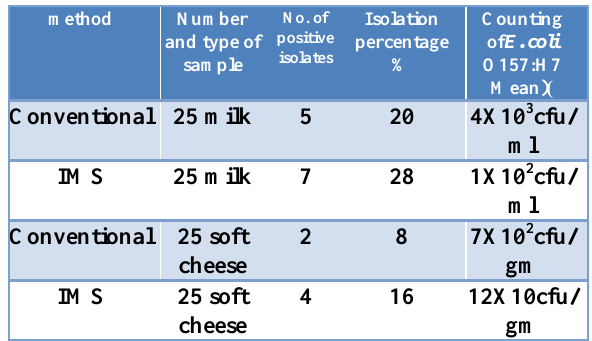
Table, 1: Prevalence of E.coli O157:H7 in raw milk and soft cheese samples by conventional and immunomagnetic separation (IMS)